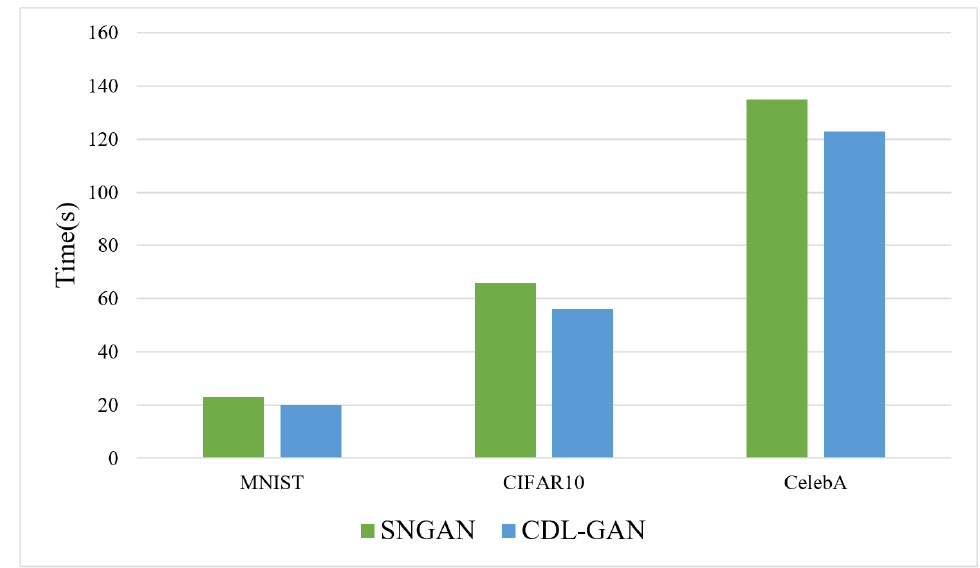
Figure 4. Training times for 100 generator update steps on different datasets. CDL-GAN and SNGAN utilize the same resblocks to build the